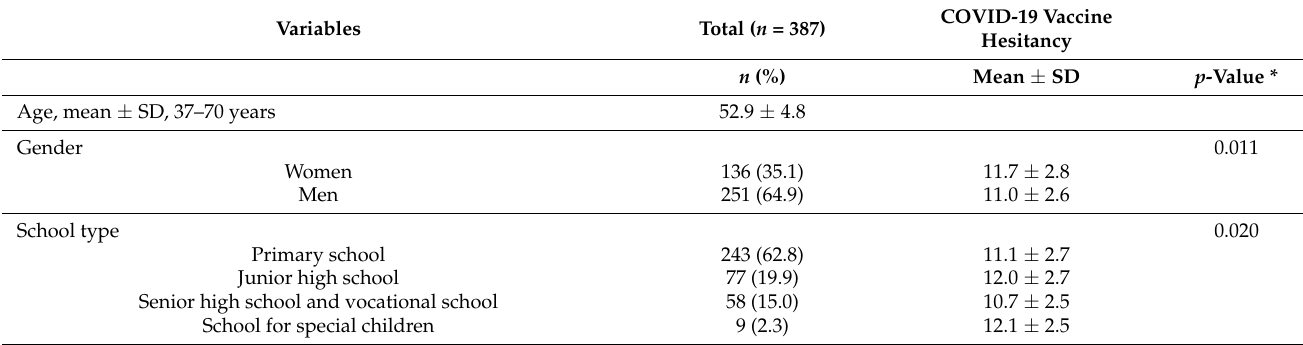
Table 1. School principals’ characteristics, their works, health, COVID-19 related information and health literacy, sense of coherence, and vaccine